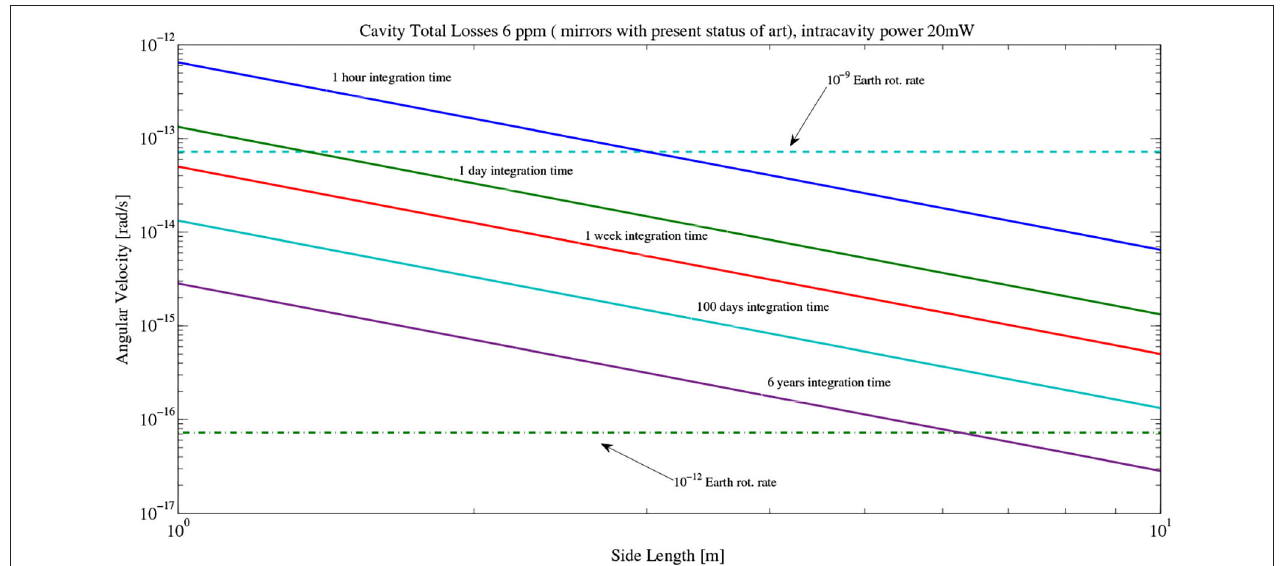
FIGURE 2 | Sensitivity limit in function of the RLG side length, assuming 6 ppm total losses of the cavity (present best mirrors), internal power 70 mW (output power 20 nW, mirror transmission 0.3 ppm). The two GINGER targets, expressed as fraction of Earth rotation rate, are over-imposed.